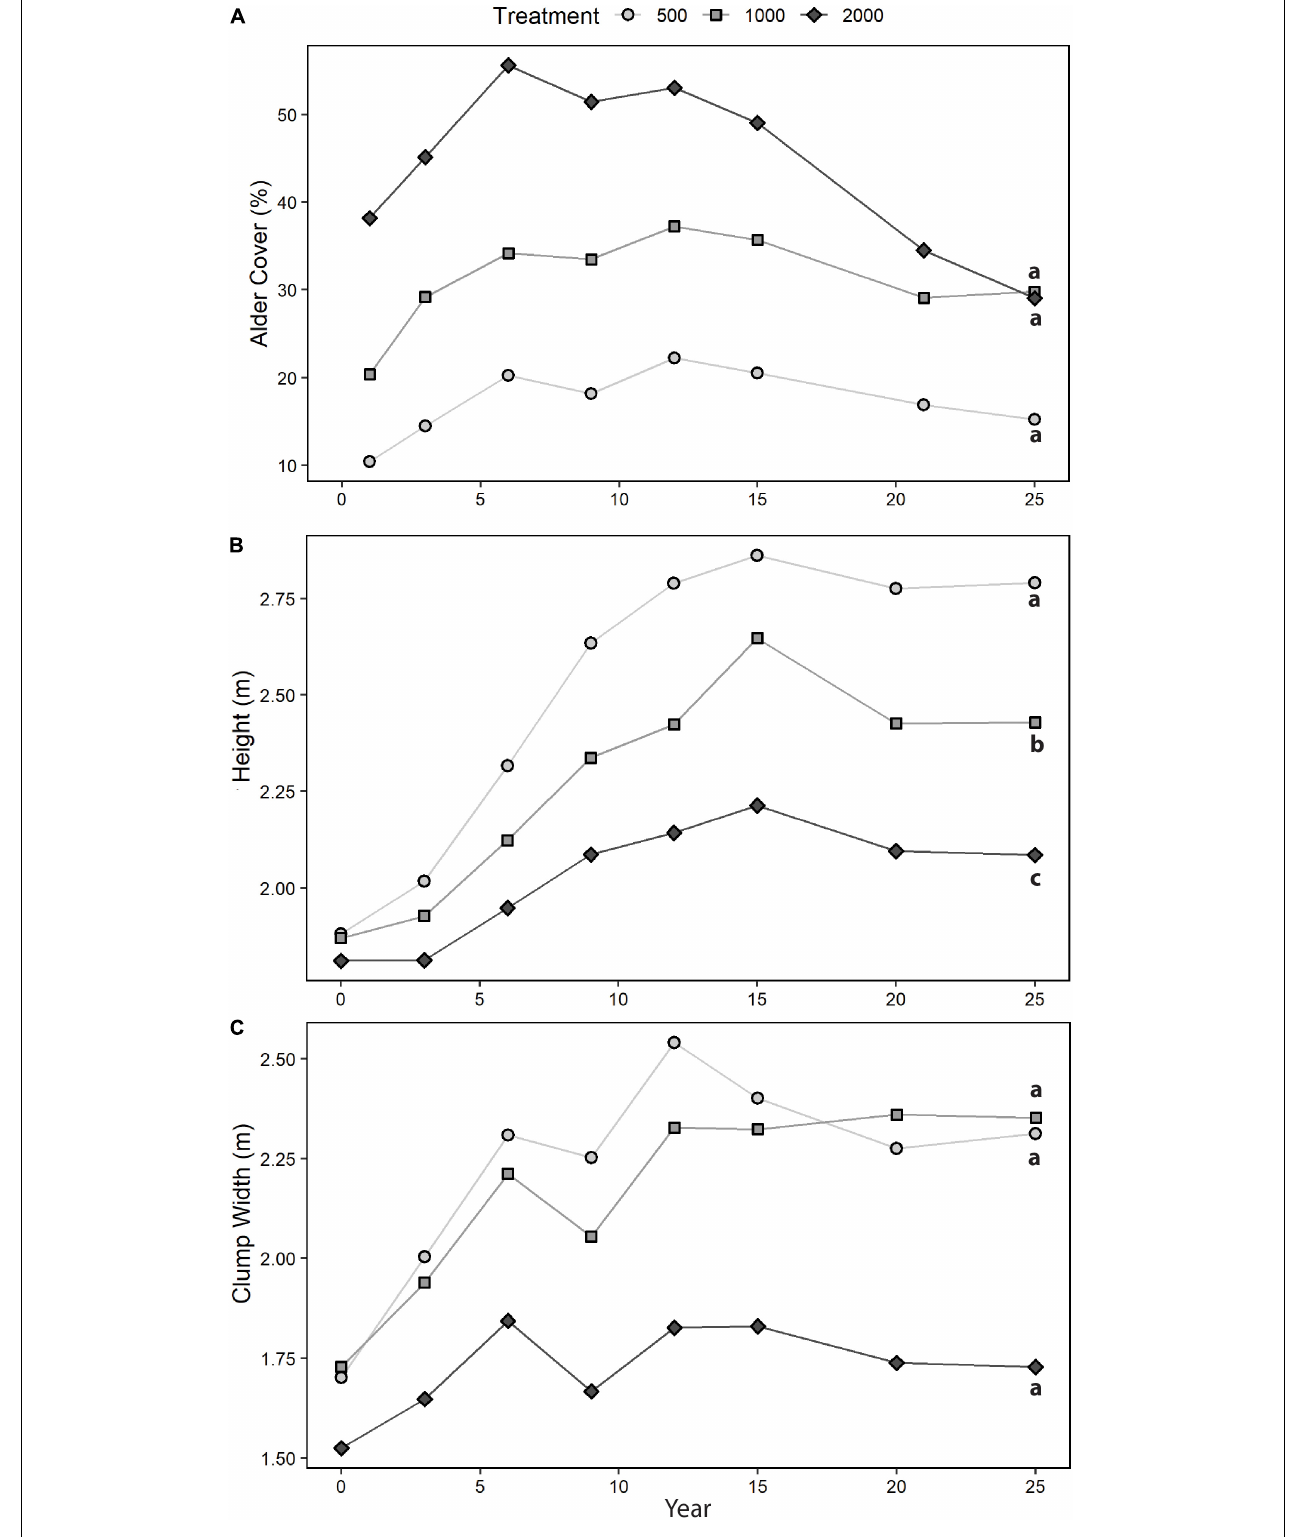
FIGURE 3 | Sitka alder growth, 1995–2020: (A) canopy cover, (B) clump height, and (C) clump width (treatment means). Different letters (a, b, c) indicate that year 0–25 increments (year 1–25 for canopy cover) were significantly different ( p < 0.05) between treatments.